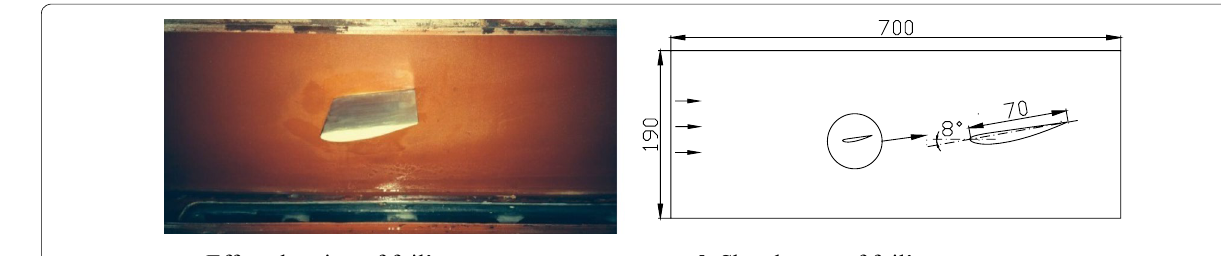
Figure 2 Effect drawing and sketch map of foil’s arrangement